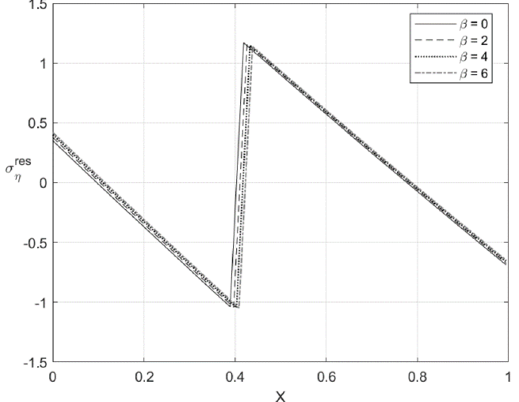
Figure 12. Through-thickness distribution of the residual stress σ res η at H / r CD = 0.06, f = 0.2, and several values of β .